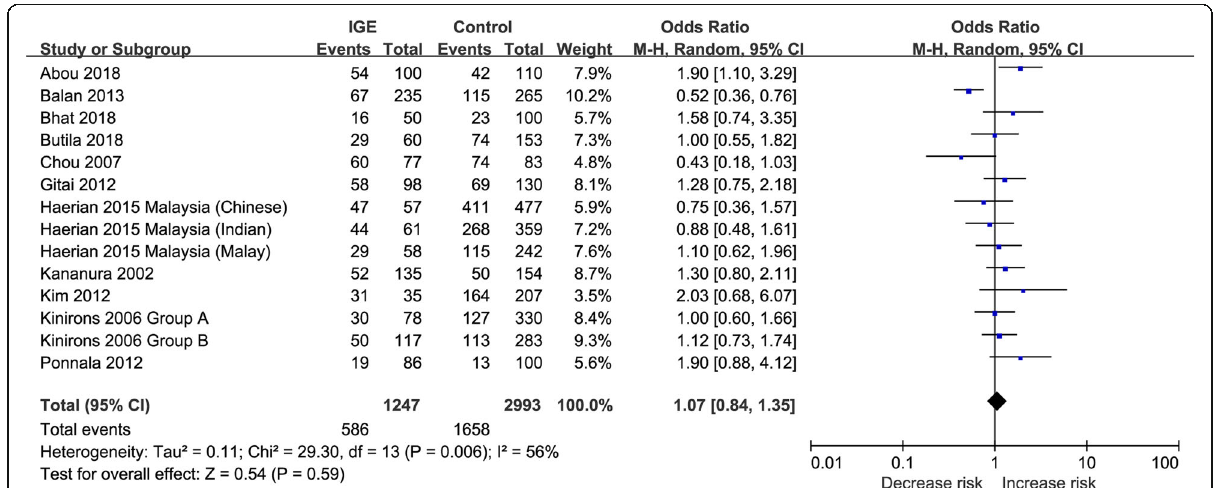
Fig. 2 Forest plot for the relationship between GABRG2 rs211037polymorphism and susceptibility to IGE. No significant association was detected between GABRG2 rs211037polymorphism and susceptibility to IGE (TT + CT vs CC)